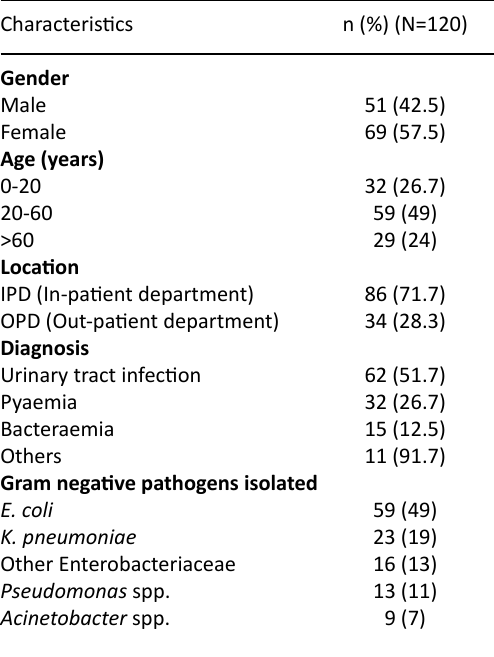
Table 1. Characteristics of the study population